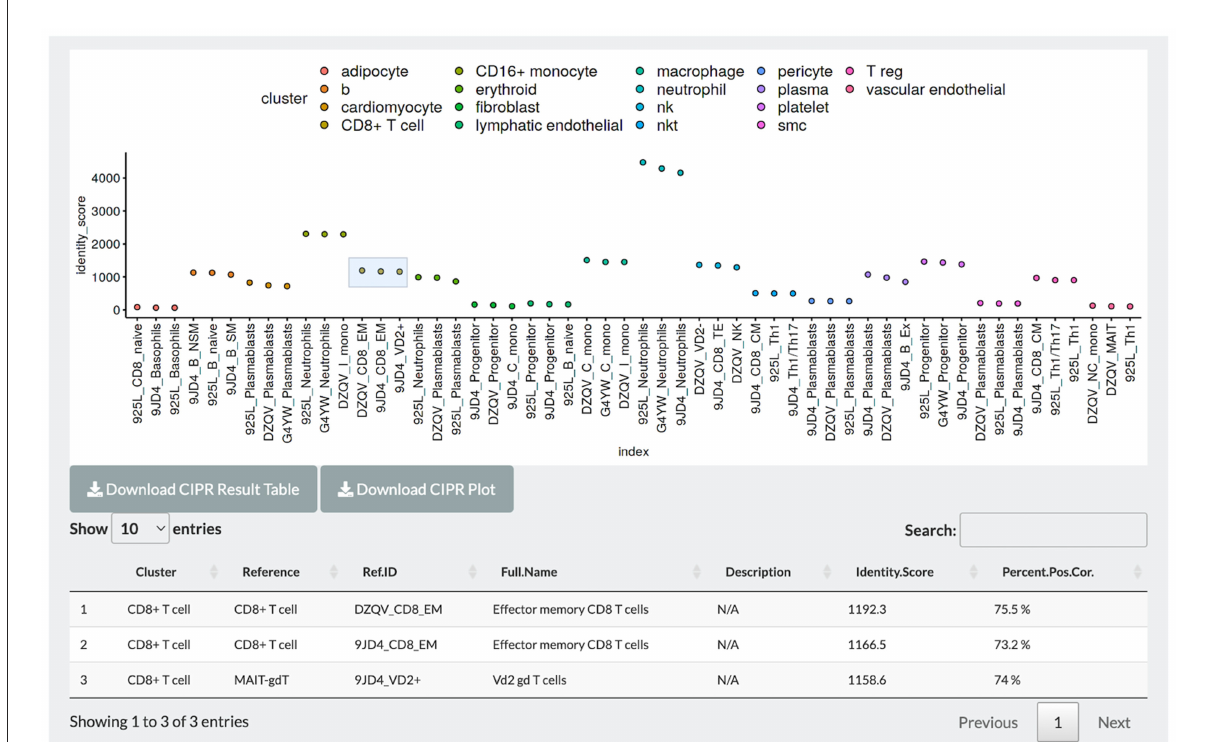
FIGURE5 CIPR integration allows further exploration and interaction with cell-level annotation. Users can benchmark pre-computed annotations with existing single-cell references, and interactively compare and visualize identity scores and percent correlations with the top candidate reference identities. Light blue box indicates selected groups for detailed